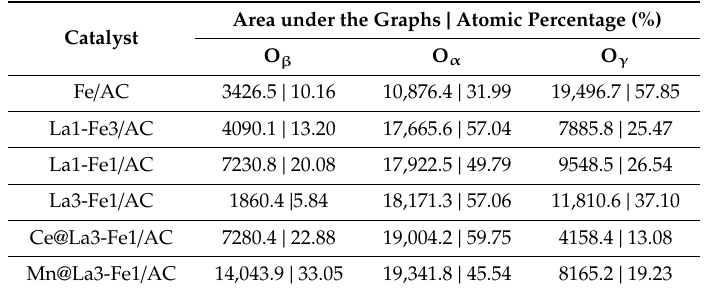
Table 2. Results of curve fitting of O 1s XPS spectra of the synthesized